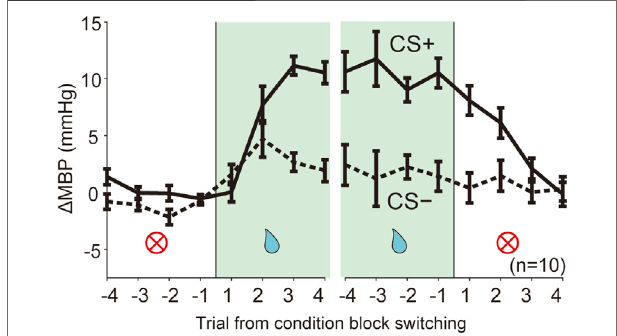
FIGURE4| Dynamicchangesofblood pressureresponsestriggeredby context block switching. Line plots showing averaged Δ MBP during four trials in each trial type CS (solid line, CS+; dashed line: CS − ) before and after switching of the reward condition block (NA → RW, RW → NA). RW, reward block; NA, neutral block. n = 10 rats.